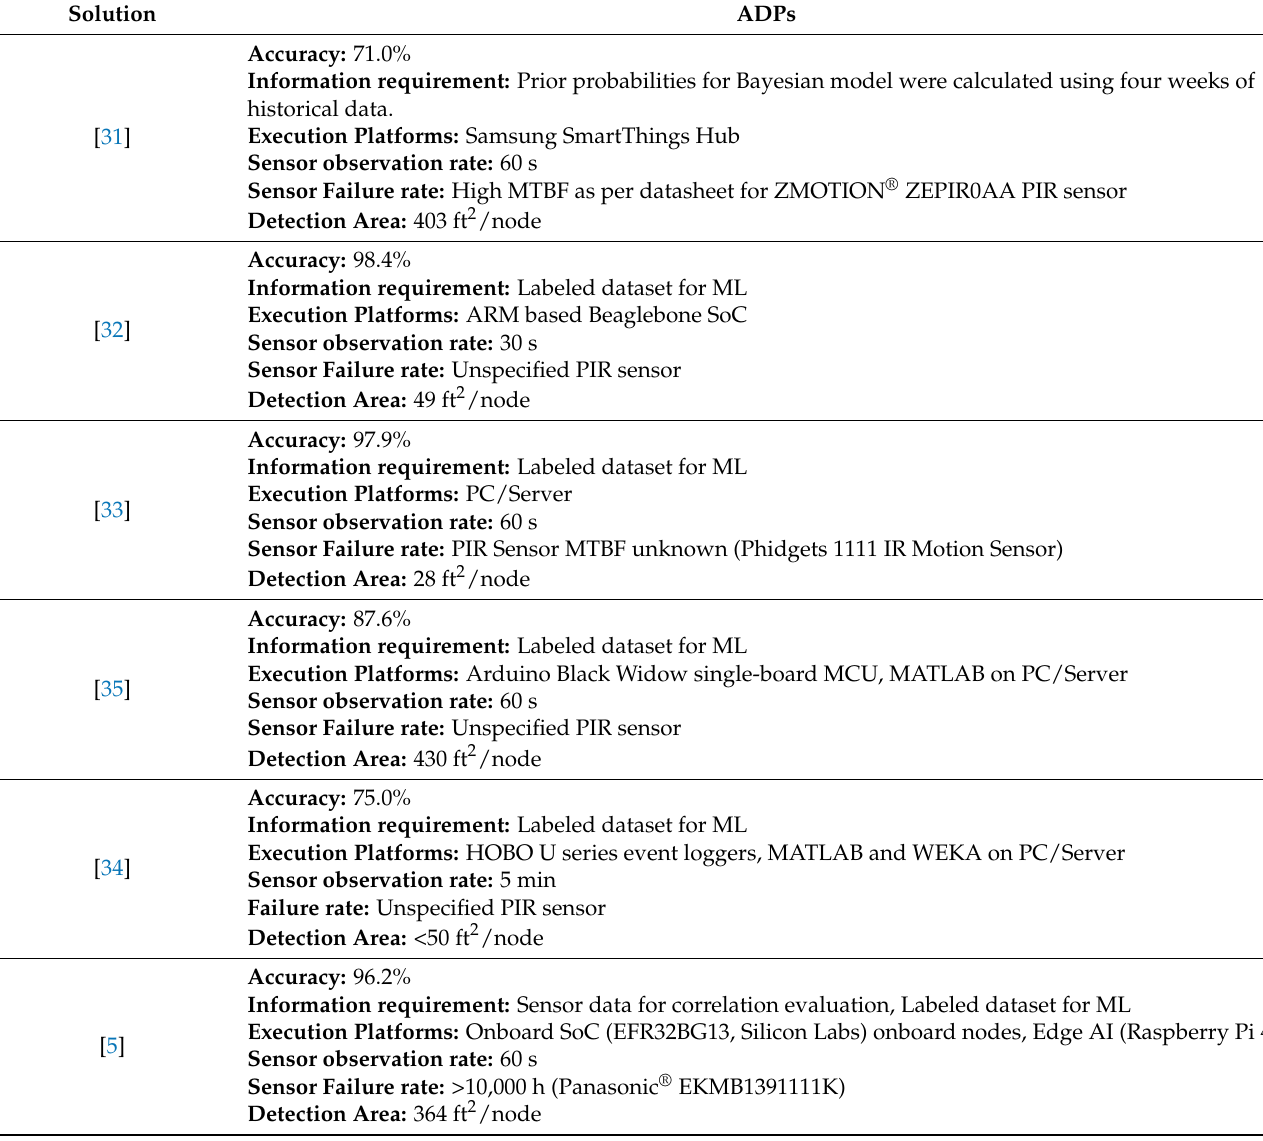
Table 5. ADPs conformance for each application area.